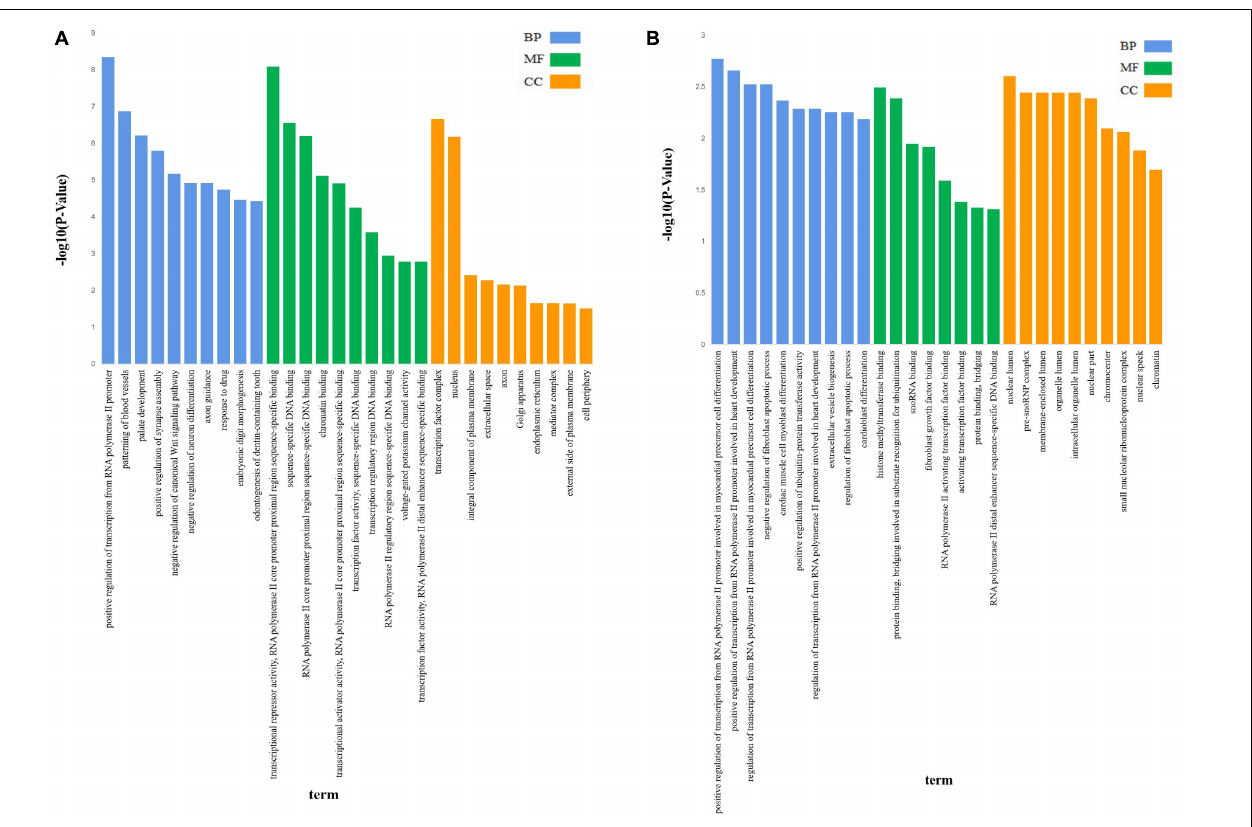
FIGURE 2 | The GO analysis of target genes of lncRNAs. GO analysis of lncRNA-target genes according to biological process (BP), cell component (CC), and molecular function (MF); (A) The GO analysis of target genes of all lncRNAs, X -axis was P- value(-log10), Y -axis was the GO term. (B) The GO analysis of target genes of DElncRNAs, X-axis was P -value(-log10), Y -axis was the GO